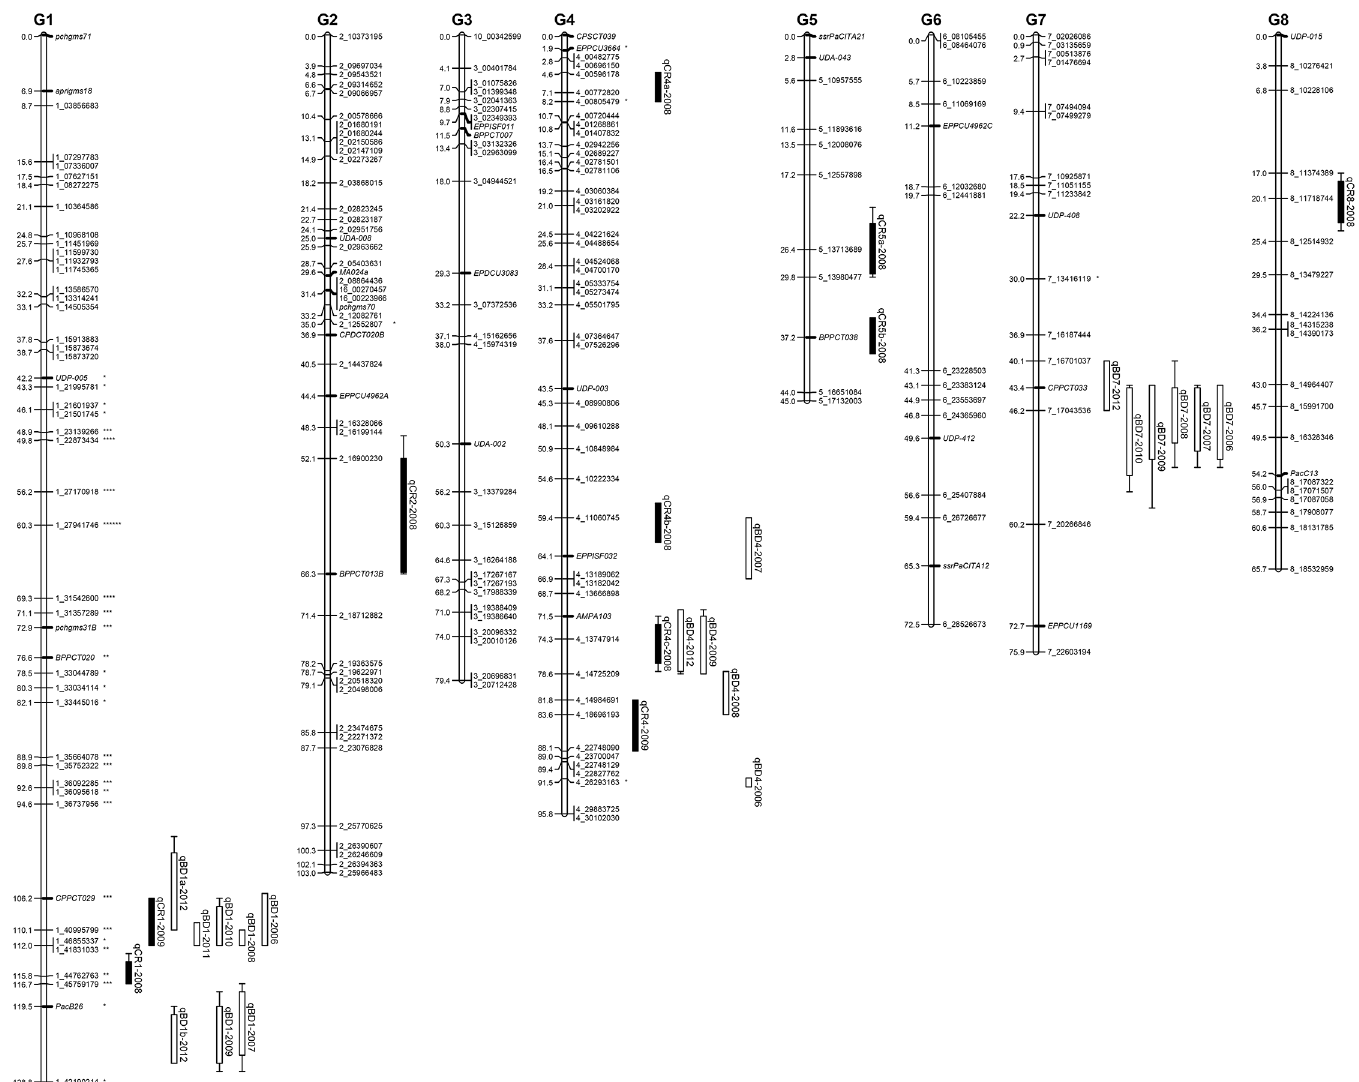
Fig 1. Linkage map of F 2 mapping population segregating for chilling requirement (CR) and bloom date (BD). Linkage group numbering corresponds to the peach reference genetic map. Left side of bars are marker distances in cM. Labels on the right side of bars are the marker name. Markers with names followed by an asterix have significantly distorted genotypic ratios ( * , p < 0.05; ** , p < 0.01; *** , p < 0.005; **** , p < 0.001; ***** , p < 0.0005; ****** , p < 0.0001). Italicized labels are SSR markers, all other markers are SNPs and are named for the scaffold and bp position on the scaffold as found in the Prunus persica genome (v1.0). QTL intervals are shown to the left of each LG. Bars and whiskers on QTL represent the 1 LOD and 2 LOD confidence intervals from the QTL peak, respectively. Chilling requirement and bloom date QTLs are represented by solid and hatched bars, respectively. A QTL is named as qXXYa — ZZZZ, with ‘ XX ’ being the trait abbreviation, ‘ Y ’ the number of the linkage group, ‘ a ’ the letter to specify different QTLs for the same trait in one linkage group (G), and ‘ ZZZZ ’ the year in which the trait was